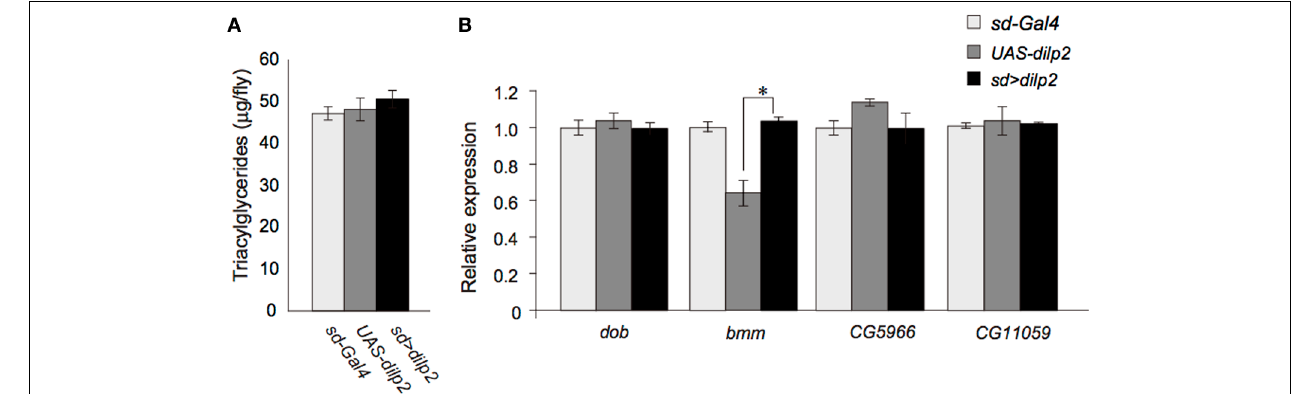
FIGURE 6 | Lipid metabolism in dilp2 -overexpressing flies. Comparison of TAG levels between the dilp2 -overexpressing flies and the parental lines as controls (A) . Relative mRNA levels of four major genes involved in lipid catabolism in Drosophila , doppelganger von